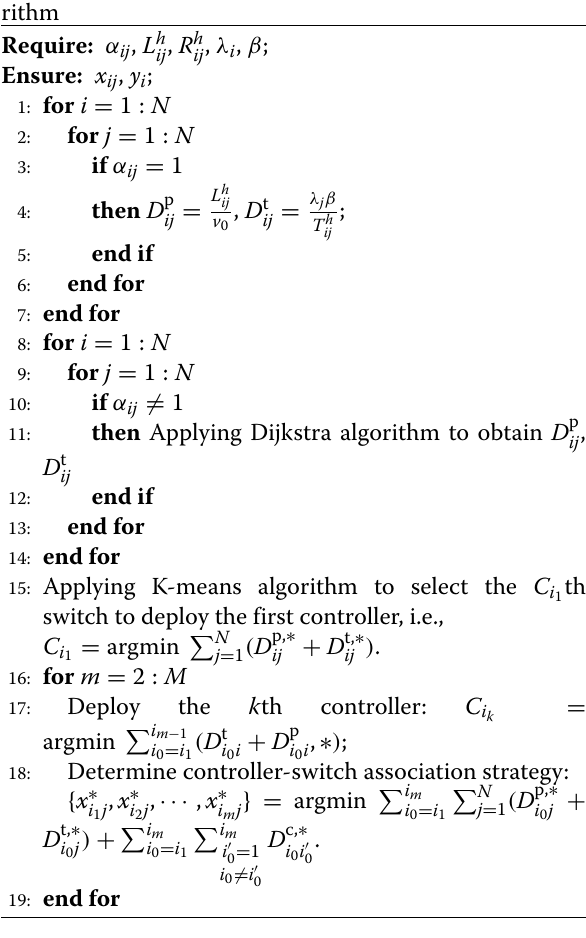
Algorithm 1 Proposed controller-switch association